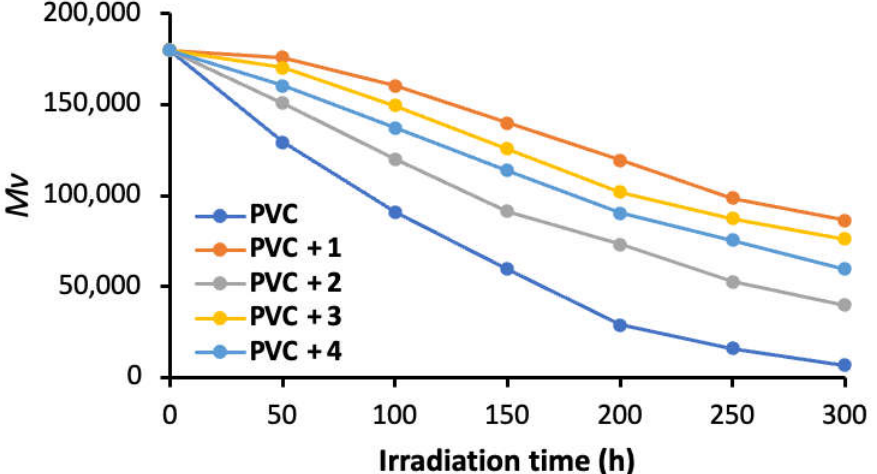
Figure 6. A plot showing Mv for PVC films as a function of irradiation time.